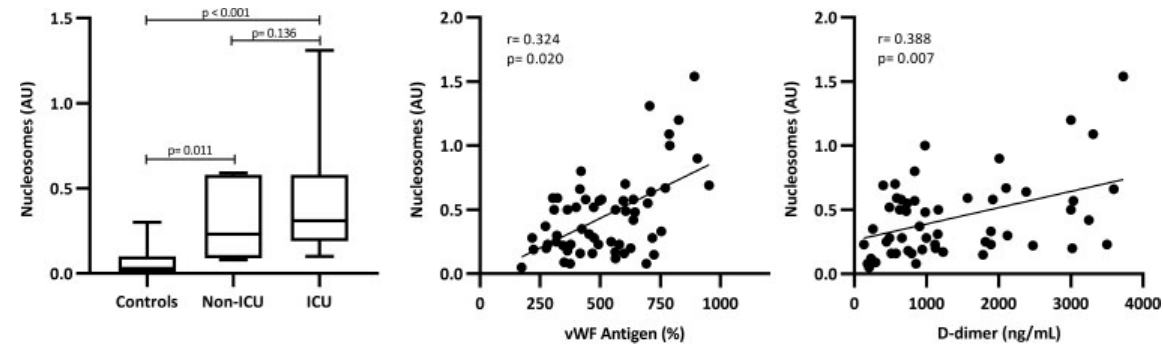
Fig. 5 Nucleosomes levels in non-ICU and ICU patients compared with controls and their correlation with vWF antigen and D-dimer levels.